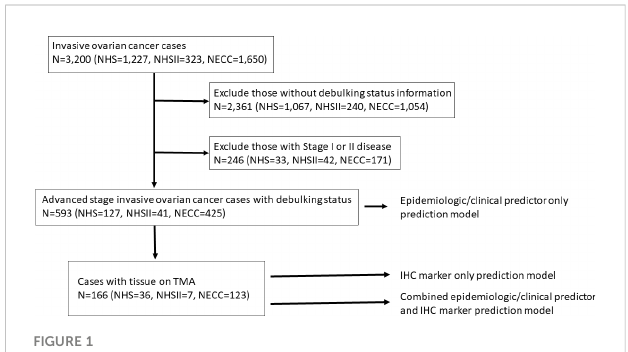
FIGURE 1 Flow chart of the exclusion criteria and study population included in the various prediction